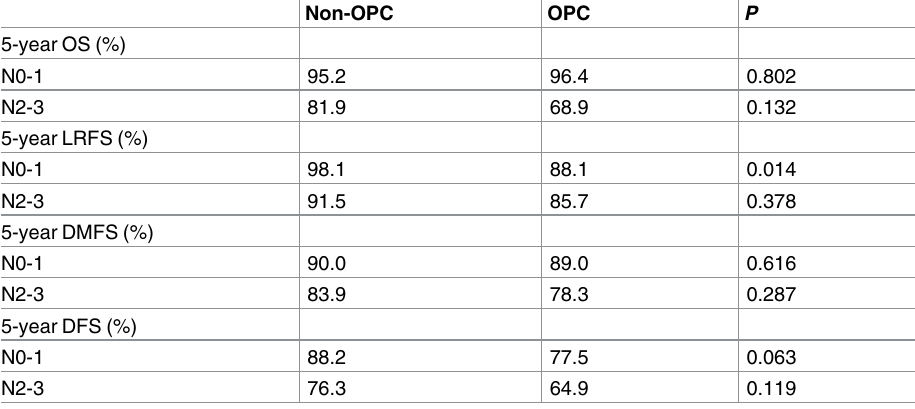
Table 5. Subgroup survival analysis in N0-1 and N2-3 patients.